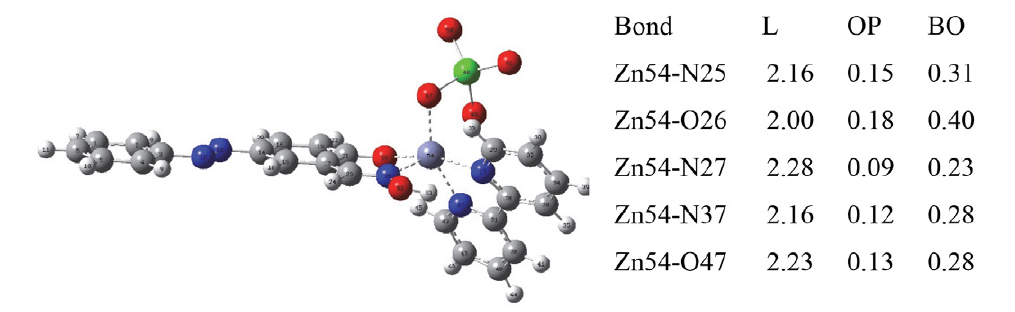
Figure 7: Optimized molecular structure of the complex 5 and selected bond length in Å (L), overlap population (OP) and bond order